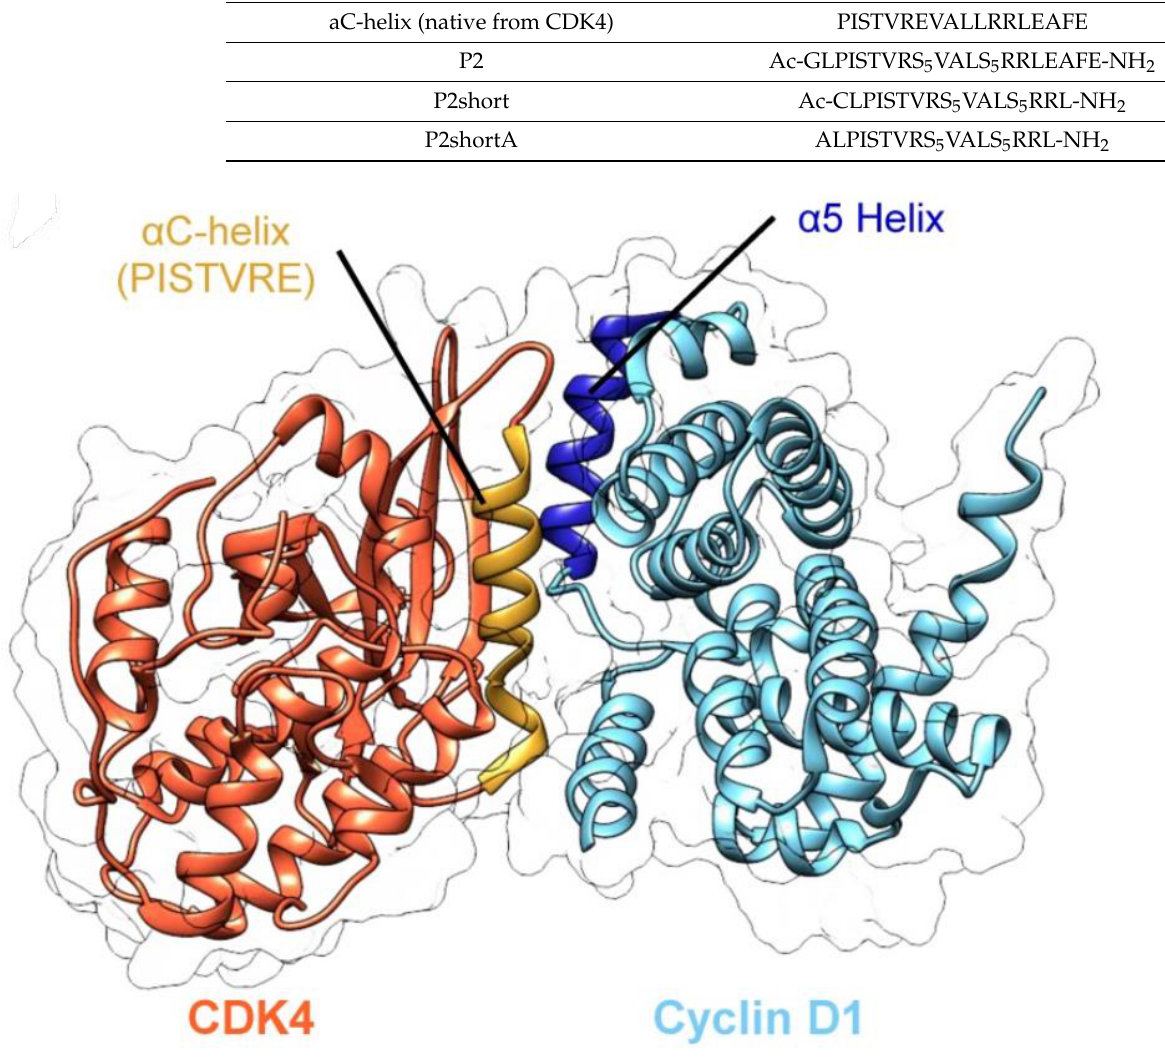
Figure 3. The overall 3D structure of CDK4/Cyclin D1 is shown with the protein–protein interface helices labeled. Adapted with permission [26].